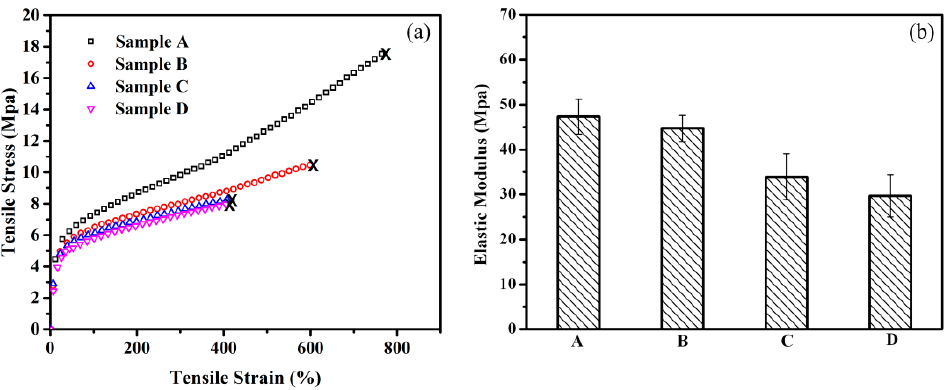
Figure 6. Tensile properties of EPDM/PP (60/40) TPV samples selected at different DV times: ( a ) stress-strain curves; ( b ) elastic modulus.